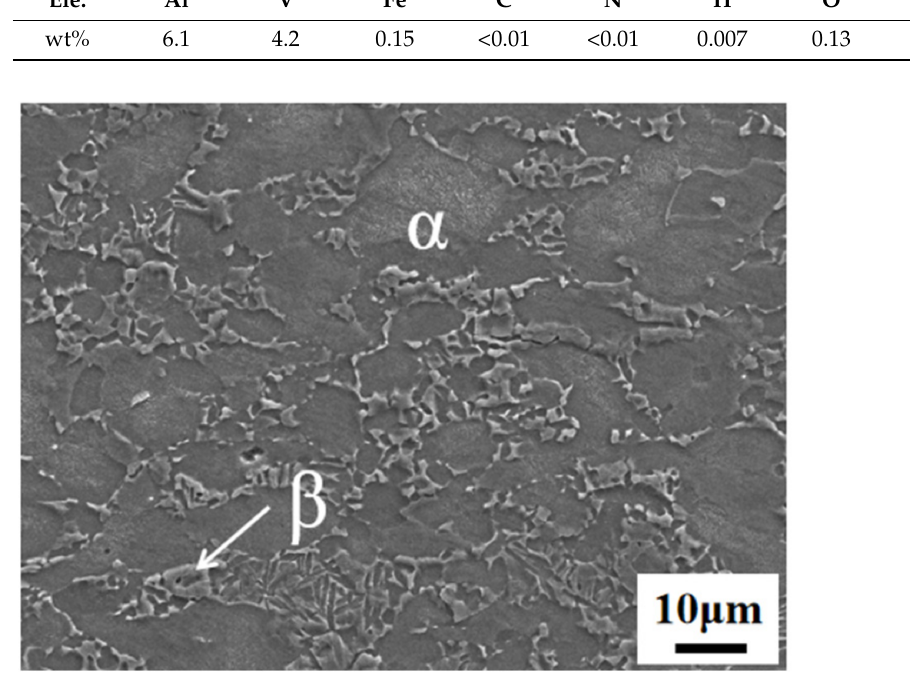
Figure 1. Microstructure of the as-received TC4 titanium